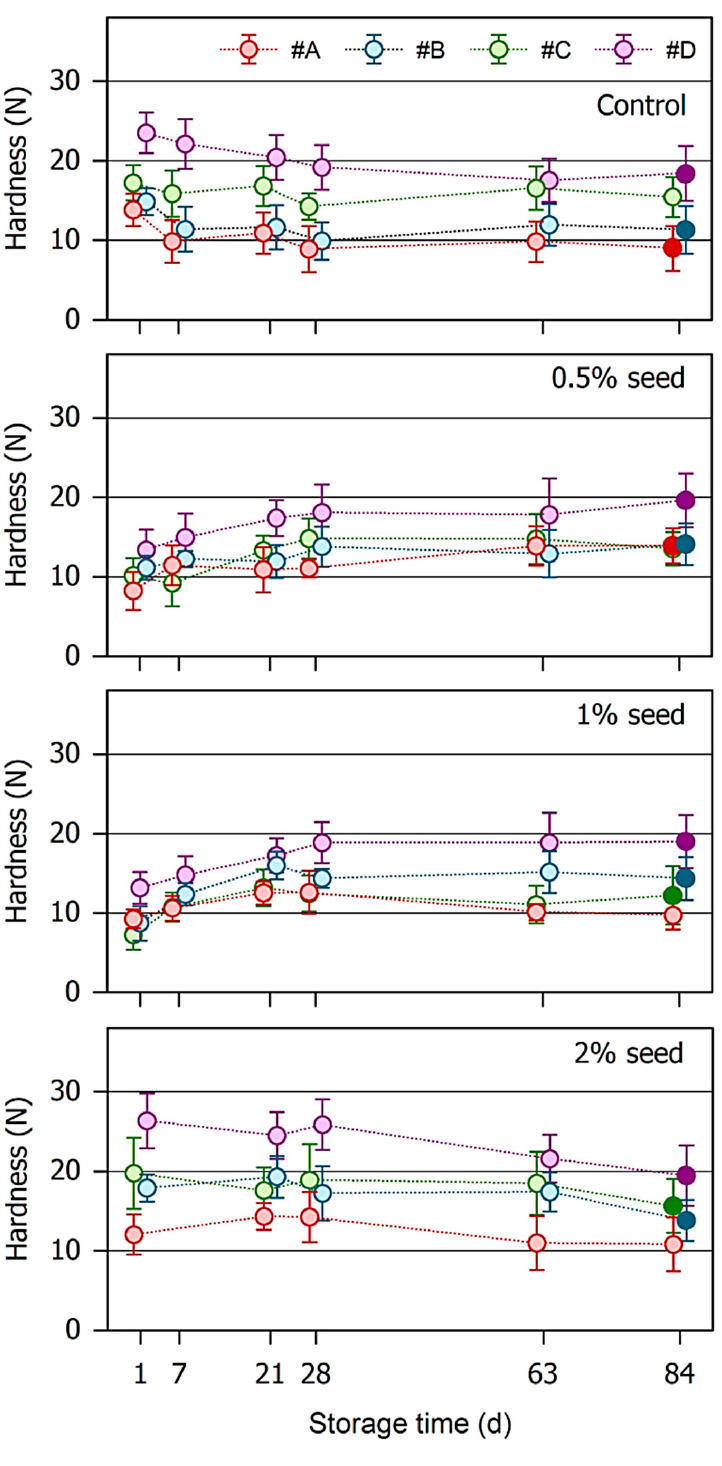
Figure 2. Development of the hardness of the nougat/chocolate layer models during storage at 23 °C for 84 days. Four different nougats (#A, #B, #C, #D) were either tempered using the stir/shear technique (control) or seeded with different amounts of cocoa butter crystals. For the sake of clarity, symbols are slightly shifted along the x-axis. Data are arithmetic mean ± standard deviation of 8-fold measurements. The hardness of samples at 84 days marked by a filled symbol is significantly ( p < 0.05) different from the hardness of the fresh layer models.